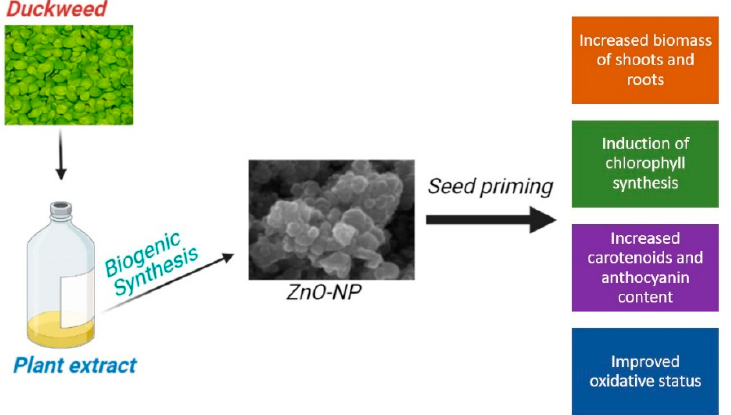
Figure 9. Summary of the positive effects of biogenic ZnO-NPs, obtained using duckweed extracts, in maize.